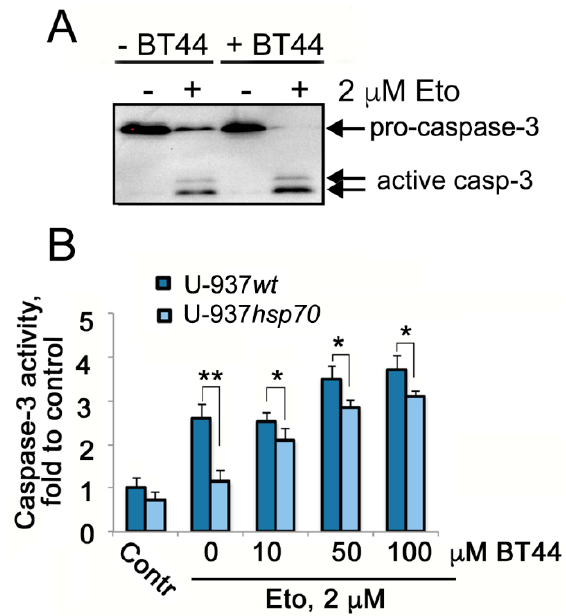
Figure 5. BT44 enhances Caspase-3 cleavage in U-937 cells treated with etoposide. ( A ) Western blot of U-937 wt cells treated with BT44 and etoposide, alone or in combination. The membrane was stained with antibody against Caspase-3; ( B ) U-937 wt and U-937 hsp70 were treated with BT44 in concentrations indicated and etoposide (2 µM), alone or in combination, and Caspase-3 cleavage was estimated with the aid of Caspase-3 enzymatic activity assay. A statistical difference was determined by a value of * p < 0.05, ** p < 0.01. The representative data of two experiments is presented.